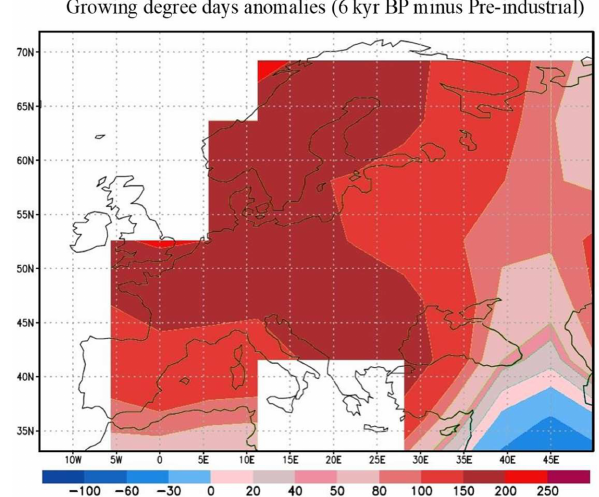
Figure 8. Simulated mid-Holocene growing degree days above 0 ◦ C (GDD0) expressed as degree day anomalies ( ◦ C) relative to the pre-industrial